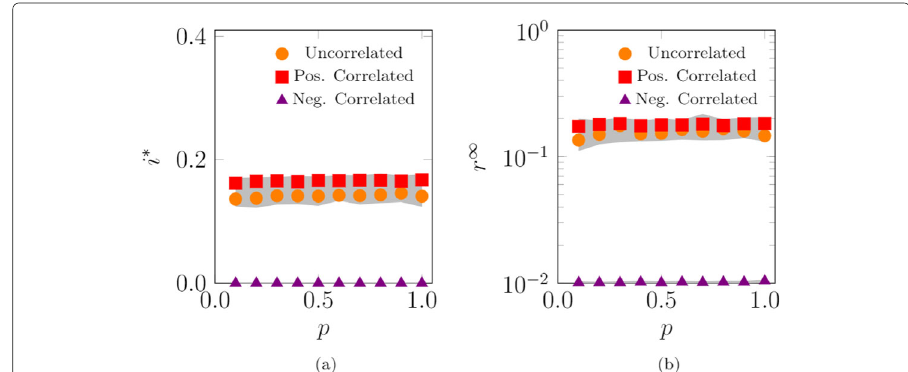
Fig. 10 Impact of different ways of assigning agents to their locations on the endemic prevalence (SIS model), a , and the epidemic size (SIR model), b . The “Uncorrelated” case represents a random assignment. In the “Pos. Correlated” case, agents with larger radii are assigned to the denser (central) locations, while, in the “Neg. Correlated” case, agents with larger radii belong to the less dense (peripheral) locations. Curves represent the median of 100 independent simulations; 95% confidence bands are displayed in gray. Agents are initially inside their base location and the infection starts after 100 steps to allow the agents to reach a steady-state configuration. The fraction of randomly chosen initial infected is 0.01. Other parameter values are L = 100, N = 10,000, D = 10 9 , (cid:6) min = 100, (cid:6) max = 10,000, σ min = 1, σ max = 1,000, v = 500, c = 4 · 10 − 4 , ω = 2.4, γ = 2.1, λ = 0.15, and μ =